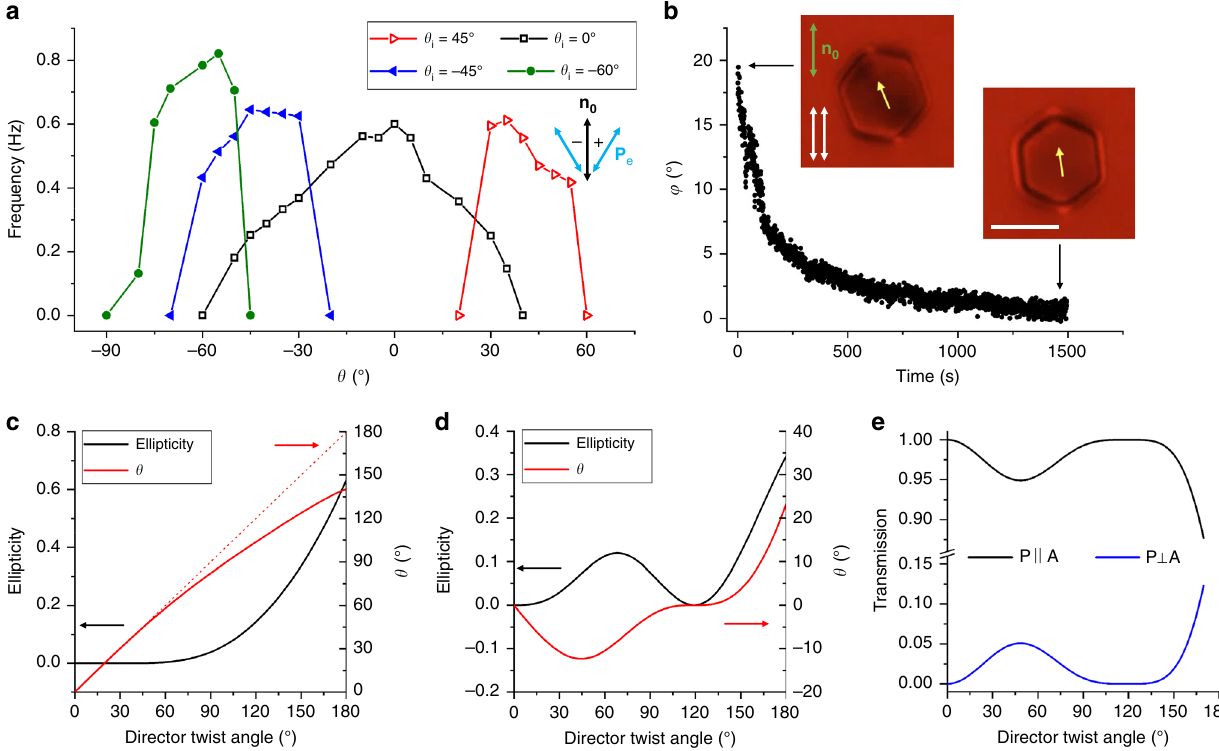
Fig. 5 Control, relaxation, and polarization dependence of colloidal spinning. a Demonstration of robust selection of handedness of colloidal spinning by illuminating the platelet with blue light linearly polarized at positive (prompts clockwise spinning of platelets) or negative (counterclockwise spinning) initial angles θ i between P e and n 0 , as well as further control of rotation frequency by then rotating P e . De fi nition of the sign of θ is shown in the inset. b Slow relaxation of azimuthal orientation angle φ of the platelet relative to its equilibrium position upon switching off the blue-light excitation. The insets show the representative polarizing optical micrographs. Scale bar is 5 µ m. c Theoretical prediction for the polarization state (ellipticity and azimuthal orientation of the long axis of the polarization ellipse θ ) of the blue excitation light when it reaches the platelet after passing the LC slab of ≈ d /2 thickness with the amount of director twist quanti fi ed by the net twist angle. The rotation of the long axis of the polarization ellipse is lagging the rotation of director within the twisted structure (shown with the red dashed line for comparison). d Calculated polarization state of the red imaging light when it exits the LC cell in the geometry shown in Fig. 1g. In the calculation, the red imaging light is assumed to pass through the LC slab above the platelet and through the one below the platelet, both with the same d /2 thickness and magnitude (though opposite signs) of director twist. e Calculated transmission coef fi cient of the red imaging light under parallel (P ∥ A) and crossed (P ⊥ A) polarizers as a function of the director twist angle (by absolute value) within each of the LC slabs. The following experimental parameters were used in these calculations: wavelength of blue excitation light 490 nm, wavelength of red imaging light 640 nm, LC birefringence Δ n = 0.2, and thickness of the LC slab d /2 = 2.4 µ m. The linear polarization of incident excitation or imaging light was set to be parallel to n 0 ( θ = 0°). Values in plots c , d , and e are calculated based on Jones matrix modeling of light propagation in a LC